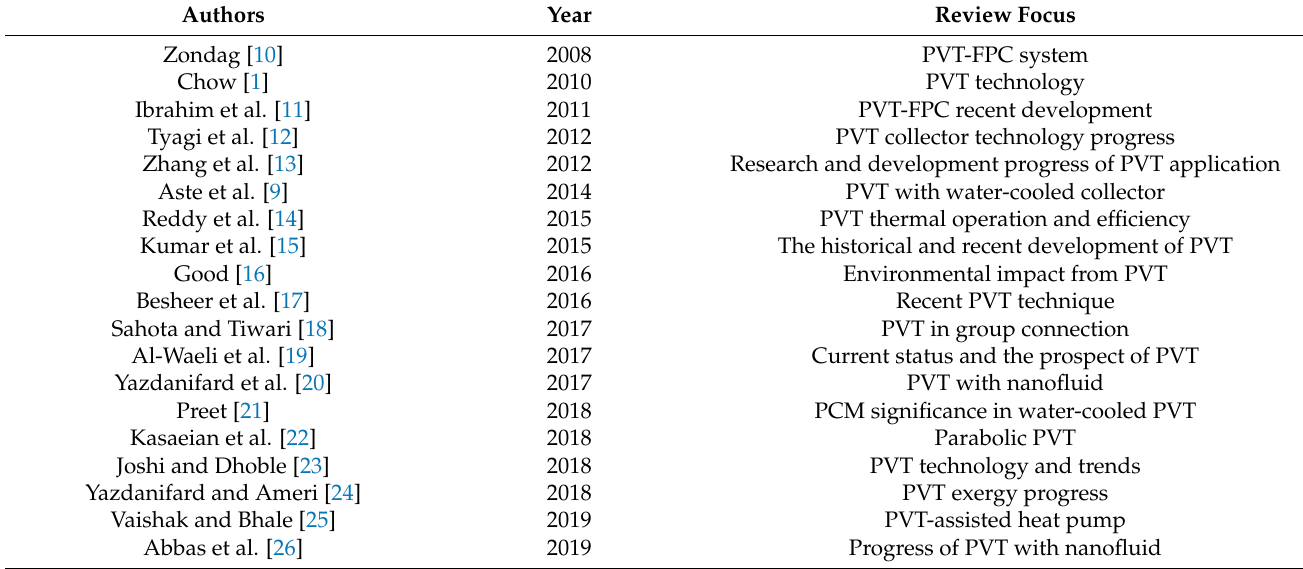
Table 1. List of previous review papers on PVT